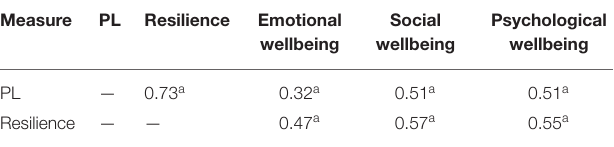
TABLE 3 | Correlations among physical literacy (PL), resilience, and mental health domains. Measure